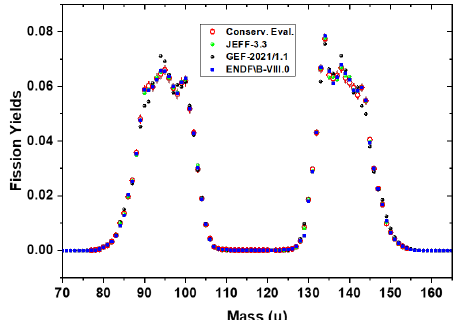
Fig. 10. Comparison of the conservative evaluation (see §2) of 235 U(n th ,f) [15] with the GEF model [14] and the JEFF- 3.3 [12] and ENDF\B-VIII.0 evaluation [19].